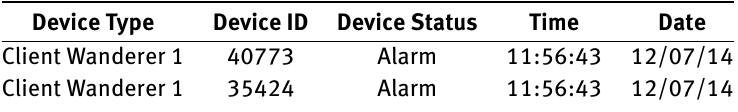
Table 2: Static Sensor Data Showing an Example of a Random